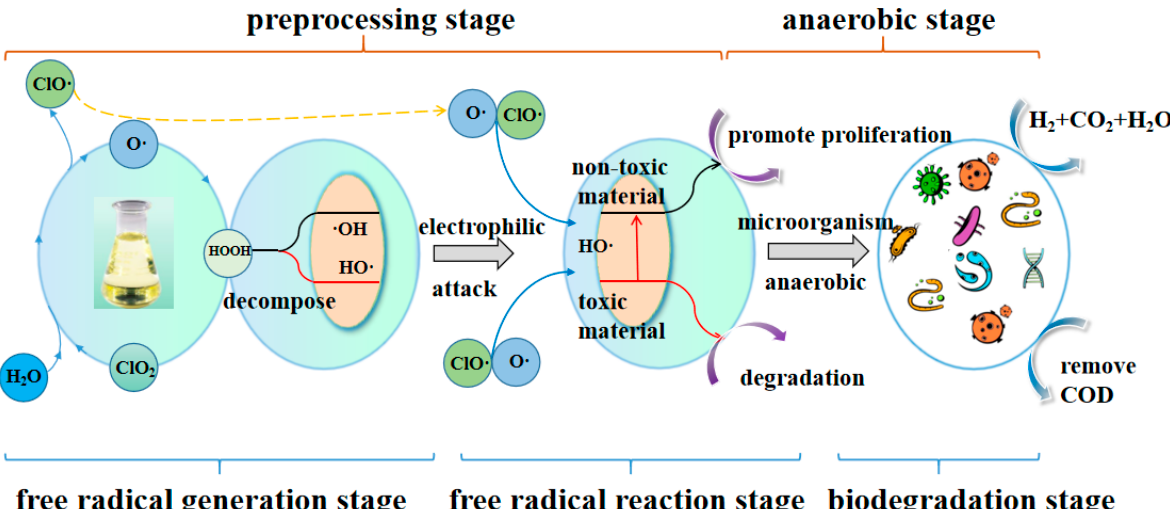
Figure 8. The reaction mechanisms of DPAT treatment.